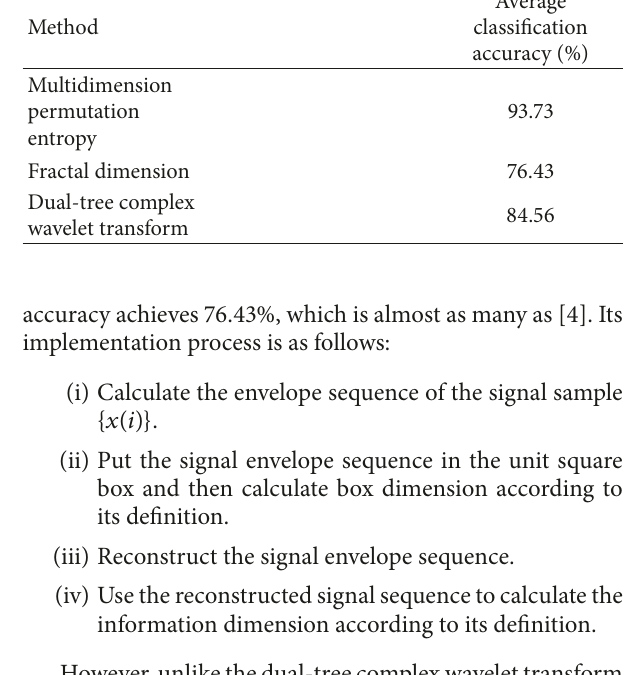
Table 1: Classification confusion matrix for random payload data: steady-state signal of radios (%).